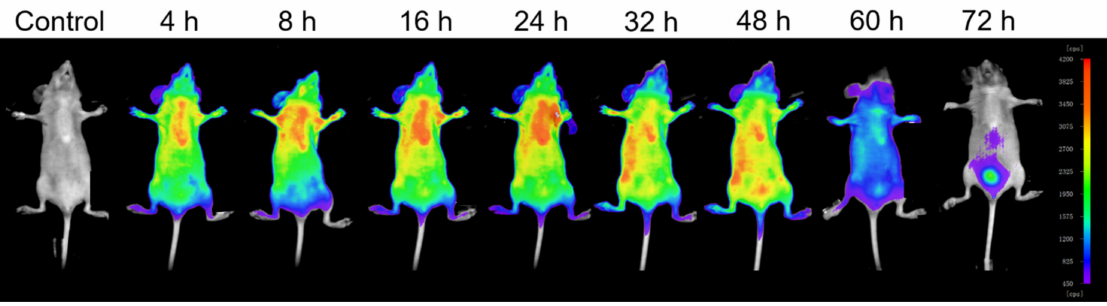
Figure 6. Fluorescence imaging of a normal nude mouse recorded before and after injection of H 2 L-MOFs.